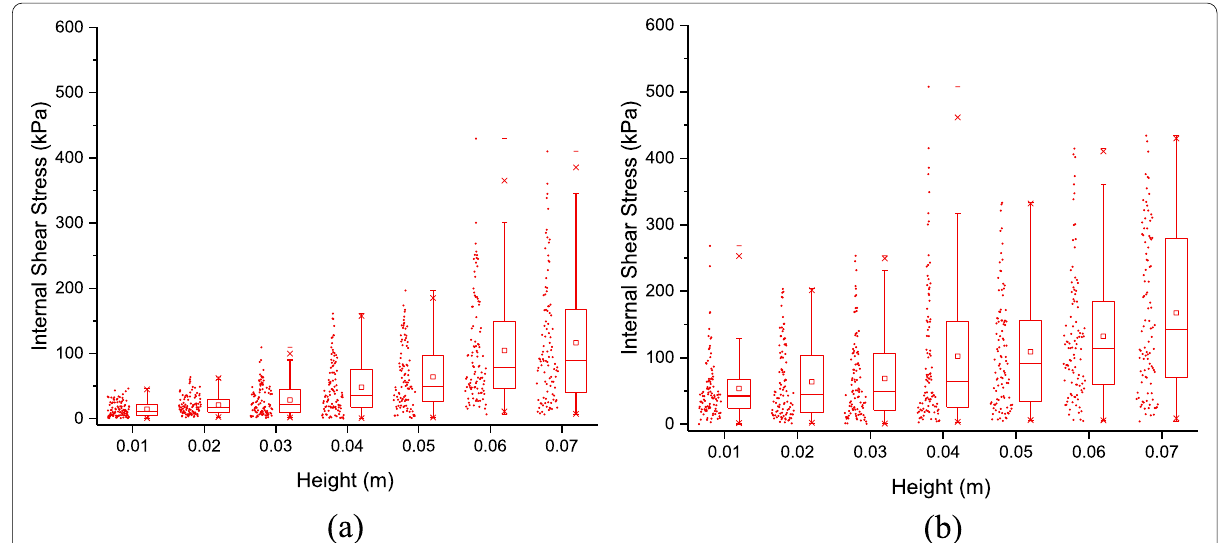
Fig. 6 Box chart of the distribution of the internal shear stress (kPa) along the height of soil specimen during the freezing process. a 10 minutes; b one hour. (The square in the center of each box indicates the mean value of the internal stress. The horizontal line inside each box is the median value of the internal stress. The upper and lower bounds of the box are determined by 75th and 25th percentiles. The whiskers are determined by the 95th and 5th percentiles)